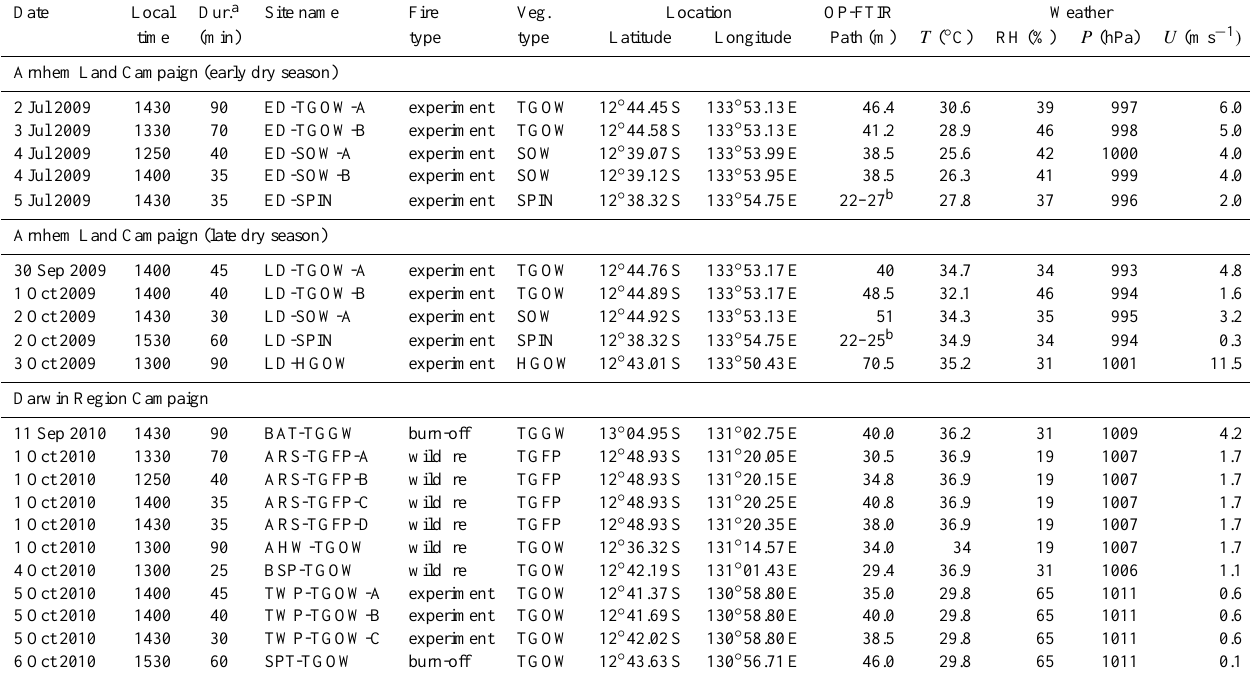
a Durationforthewildfiresandburn-offfiresreferstothelengthofthedataset. b